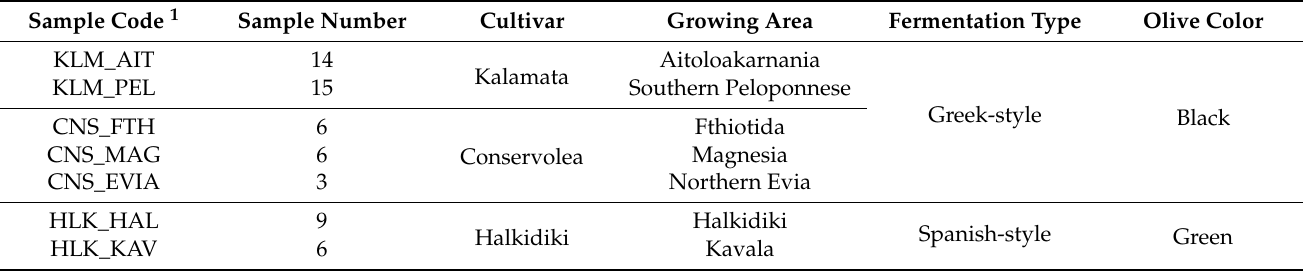
Table 1. Coding and geographical origin of the fermented cv. Kalamata, cv. Conservolea and cv. Halkidiki olive samples. Sample Code